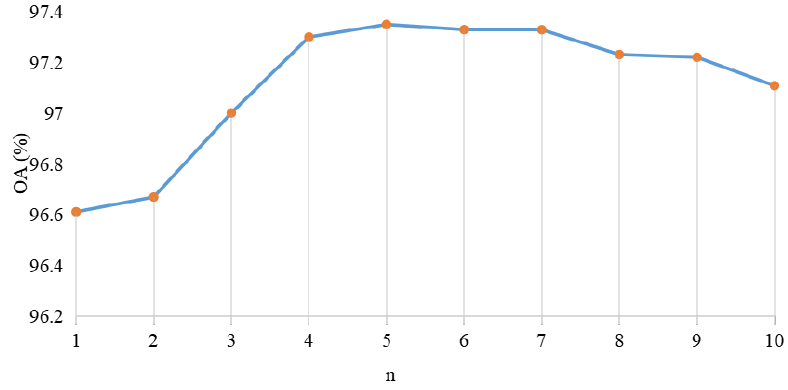
Figure 10. OA values under different n . The best result is obtained when n =